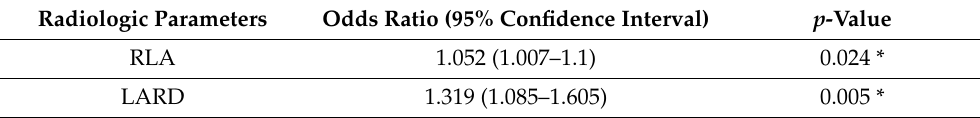
Table 3. Radiologic parameters associated with development of idiopathic CTS on logistic regression analysis.